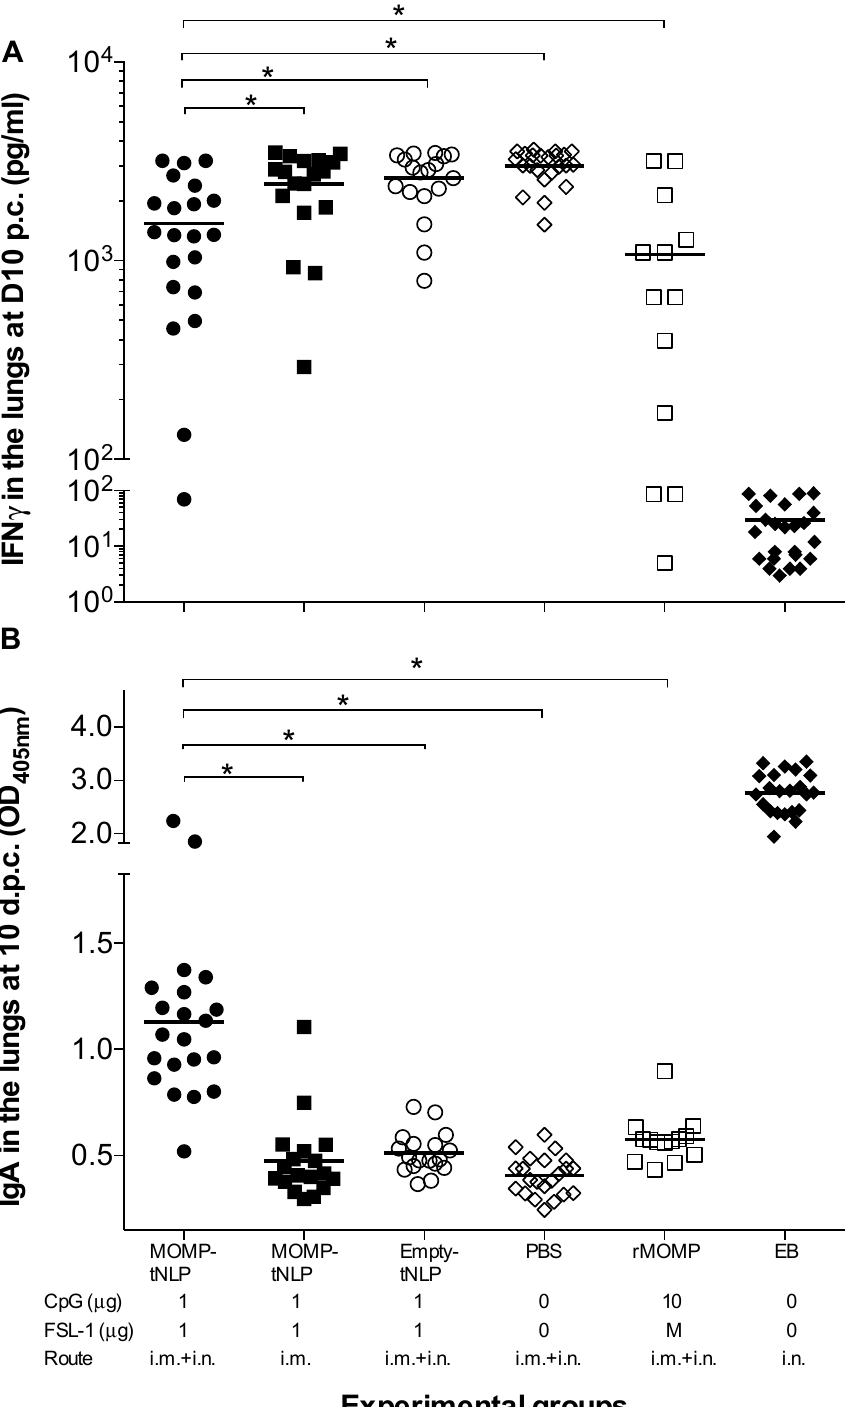
Figure 6. Levels of IFN- γ and titers of C. muridarum -specific IgA in the lungs at D10 p.c. ( A ) Levels of IFN- γ (pg/mL) detected in lung supernatants at D10 after the i.n. challenge. The mean is shown as a horizontal line. Each symbol represents a single animal. ( B ) Levels of C. muridarum -specific IgA (OD 405 ) detected in lung supernatants at D10 following i.n. challenge. The mean is shown as a horizontal line. Each symbol represents a single animal. * p < 0.05.